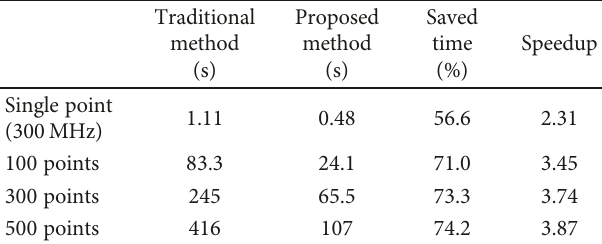
Figure 13: The phase distribution of current on the x - y